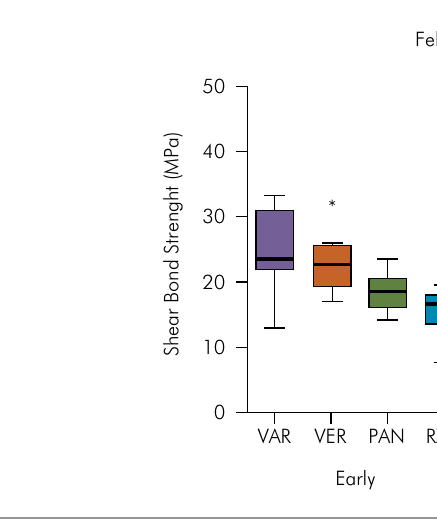
Figure 1. Boxplots of early and late shear bond strength of resin cements to feldspathic